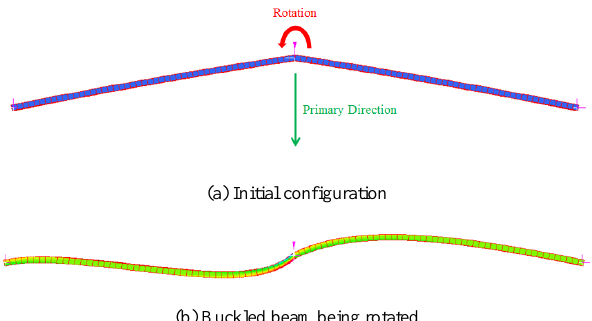
Figure 2. Off-axis rotation.